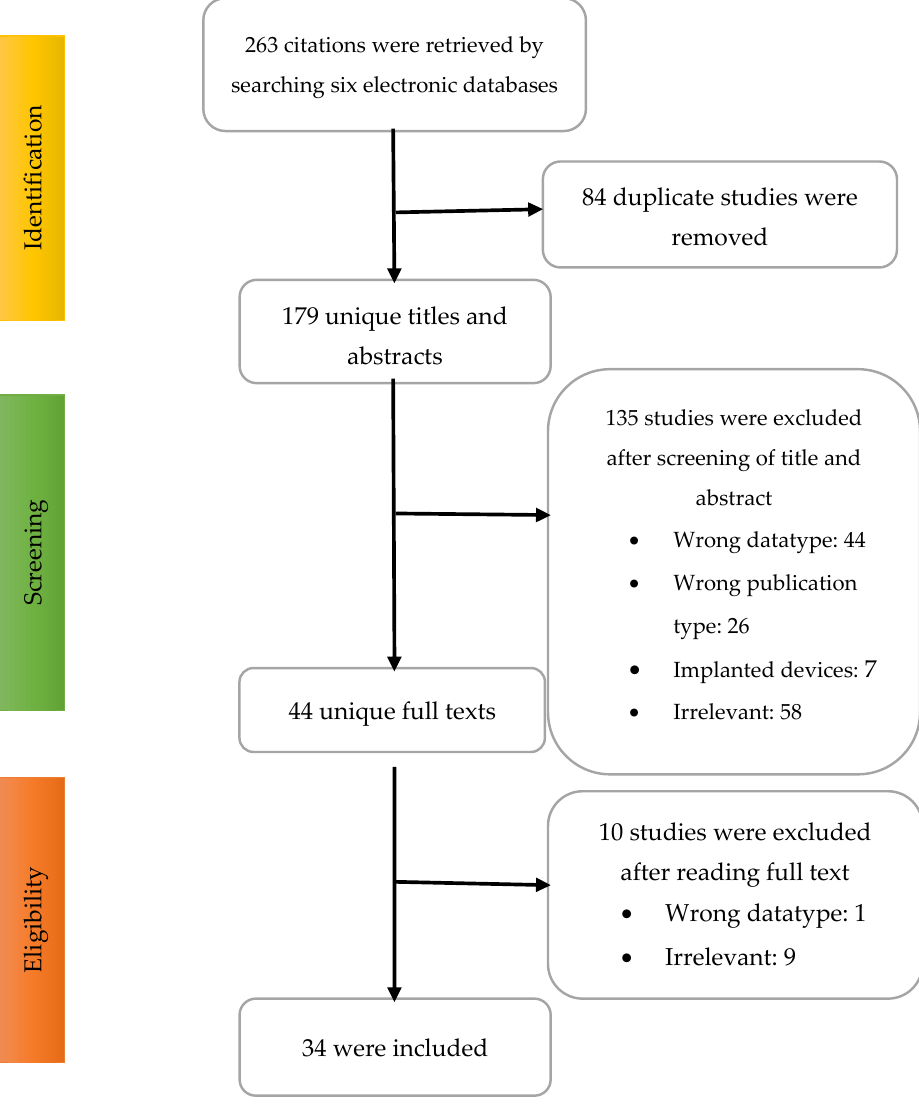
Figure 1. Study selection flow